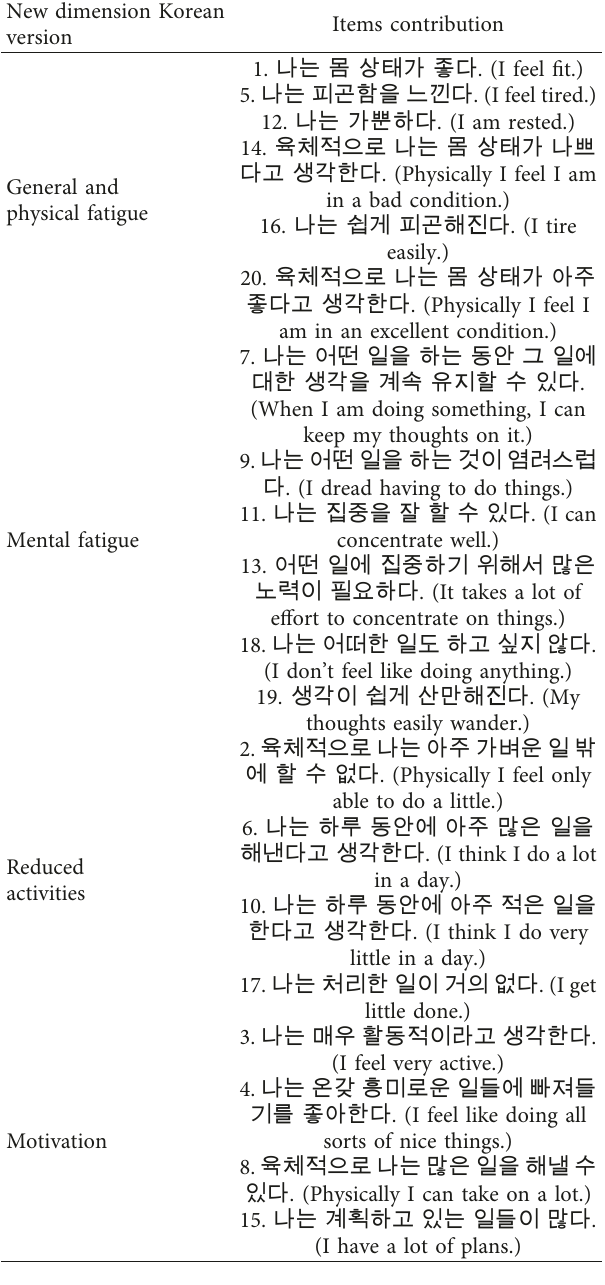
Table 3: Items of the new dimension of the MFI Korean